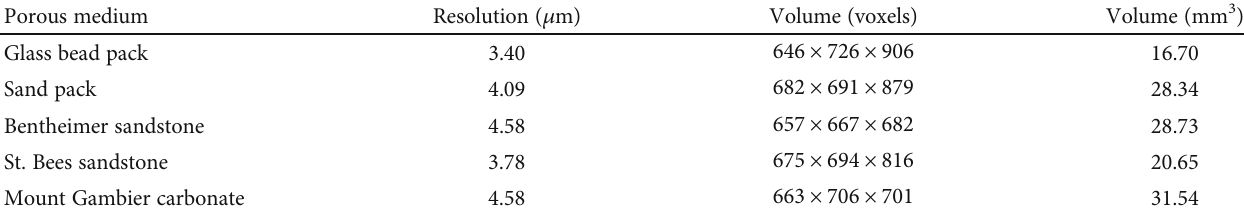
Table 1: Details of the digital porous media.